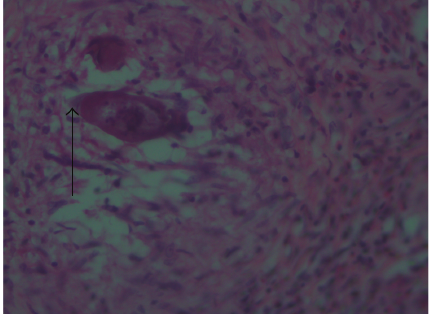
Figure 3: H and E stain showing typical S. hematobium egg with terminal spine (see the arrow) ( ×